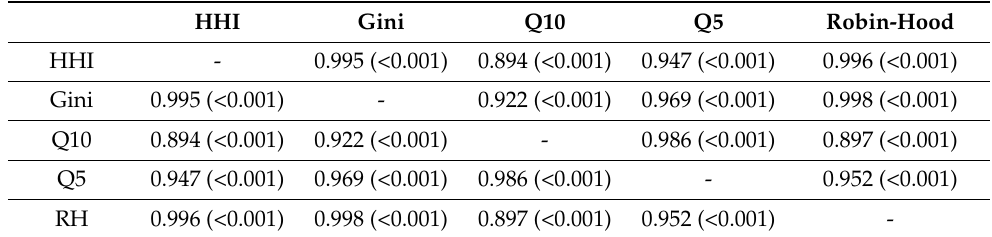
Table A4. Correlation (and p -value) of net income inequality distribution indices between 2005 and 2017, households with sports expenditures only.